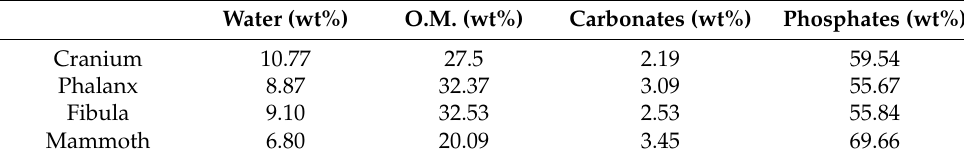
Table 3. Thermogravimetric analyses indicating the relative weight loss of water, organic matrix (OM), carbonates, and phosphates in bone samples (see further details in Figure